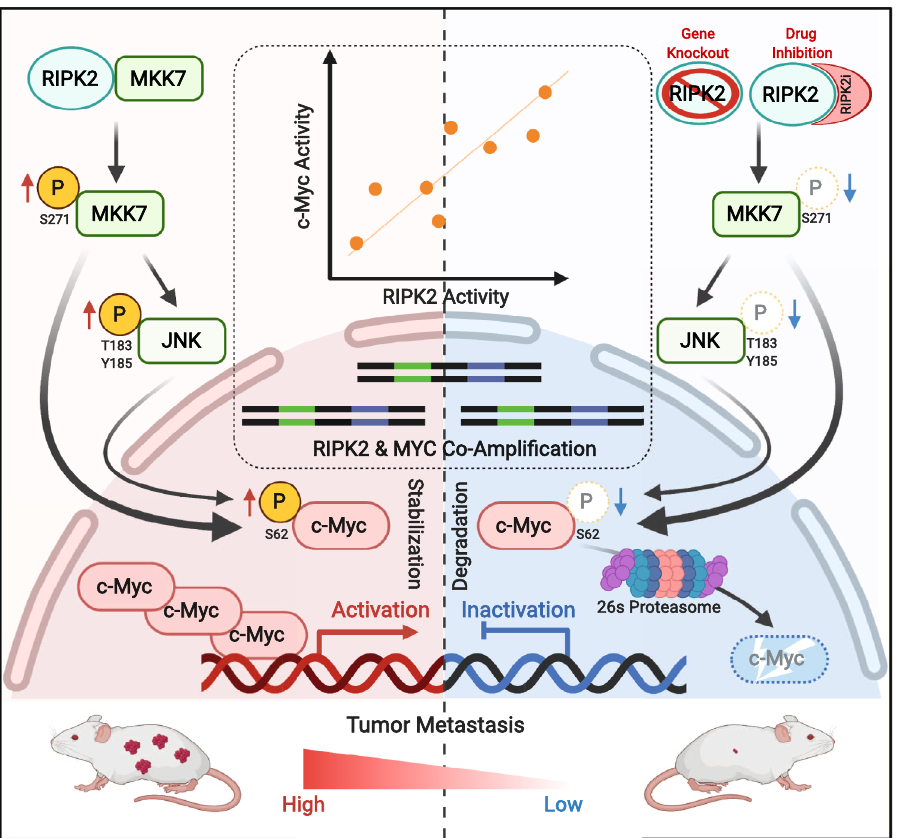
Fig. 9 Schematic summary of the fi ndings in this study. RIPK2 binds to MKK7 and activates the MKK7(/JNK)/c-Myc phosphorylation cascades, thereby stabilizing the c-Myc oncoprotein and enhancing c-Myc activity, which is required for PC metastasis. The non-canonical RIPK2/MKK7/c-Myc signaling pathways can be blocked by genetic or pharmacological inhibition of RIPK2, resulting in the proteasomal degradation of c-Myc and the inhibition of c-Myc activity and PC metastasis. Of clinical relevance, RIPK2 and MYC are frequently co-ampli fi ed/gained in PC and several other cancer types, and their activity scores are strongly correlated across many cancers. Created with